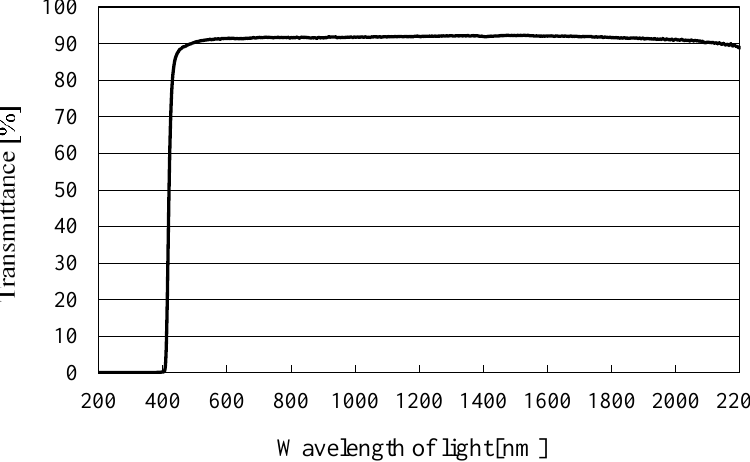
Figure 15. Characterization of edge cut filter to cut off the wavelength of light under 400 nm [49,50].